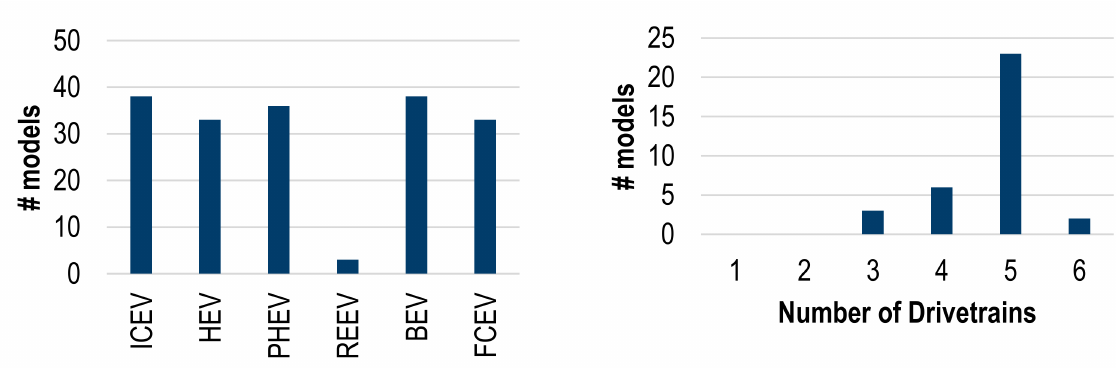
Figure A3. The relevance of different drivetrain architectures for passenger cars in transport sec- tor